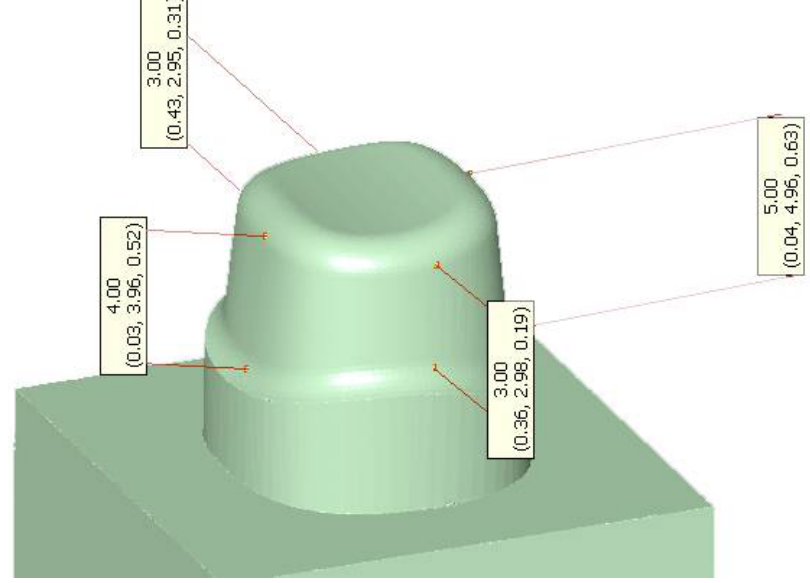
Figure 2. Design of the CAD-CAM milled tooth stump and its baseplate (FDI #46). Single-tooth crowns made from three materials, i.e., VarseoSmile Crown plus (VA; BEGO, Bremen, Germany), Lava Ultimate (UL; 3M GmbH, Neuss, Germany), and Enamic (EN; Vita Zahnfabrik, Bad Säckingen, Germany), were fabricated. The CAD design of the crowns was carried out (Modelier CAD-Software v.6173_6843_x64; Zirkonzahn GmbH, Gais, Italy) on the basis of a molar from an existing database. A thickness of 1.0 mm was